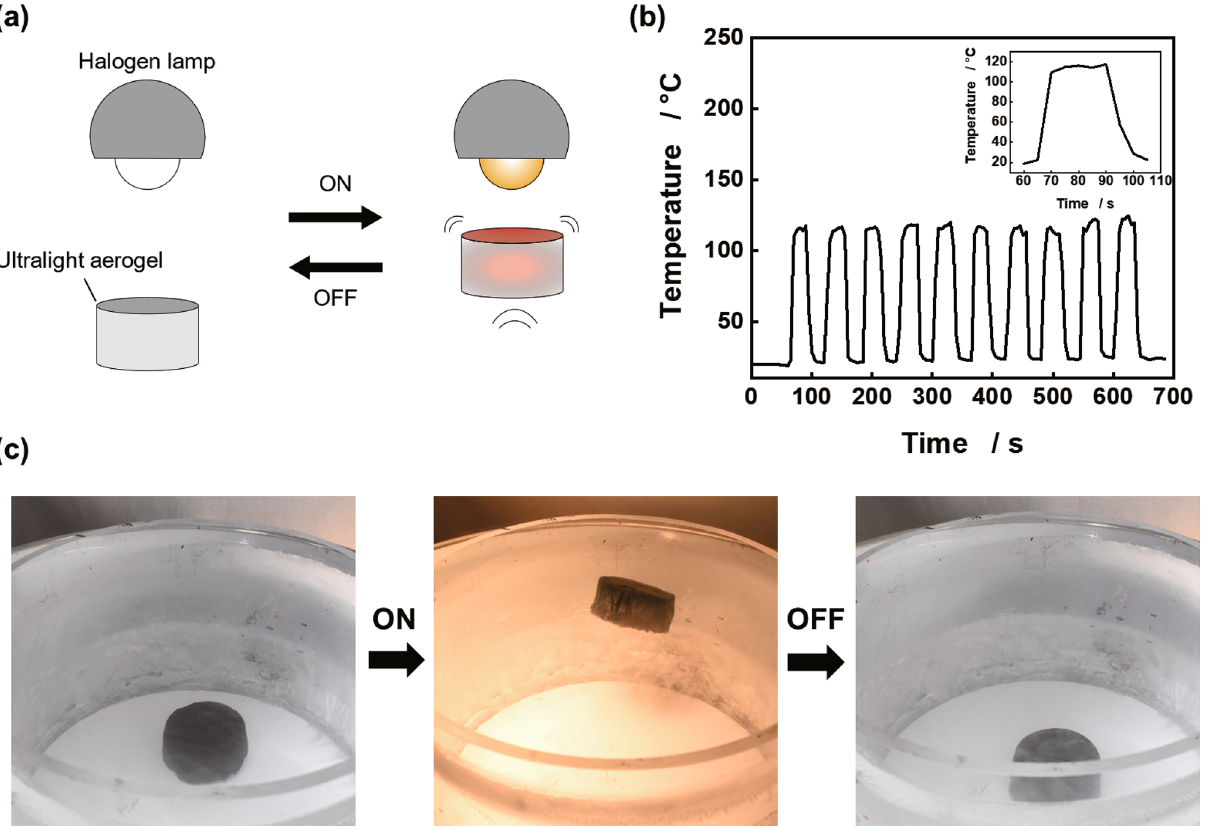
Figure 5. Results of the levitation experiments by turning a lamp on and off. ( a ) Schematic diagram of the levitation experiment with the ON–OFF cycling of the lamp. ( b ) Temperature response of the ultralight aerogel to the ON–OFF cycling of the lamp; inset: zoomed-in view of temperature variation in the range of 60–105 s. The data were obtained from ULM 0.75. ( c ) Optical image of the response of the ultralight aerogel to the ON– OFF cycling of the